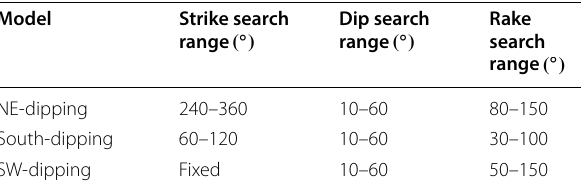
Table 2 Search ranges of the nonlinear model parameters Model